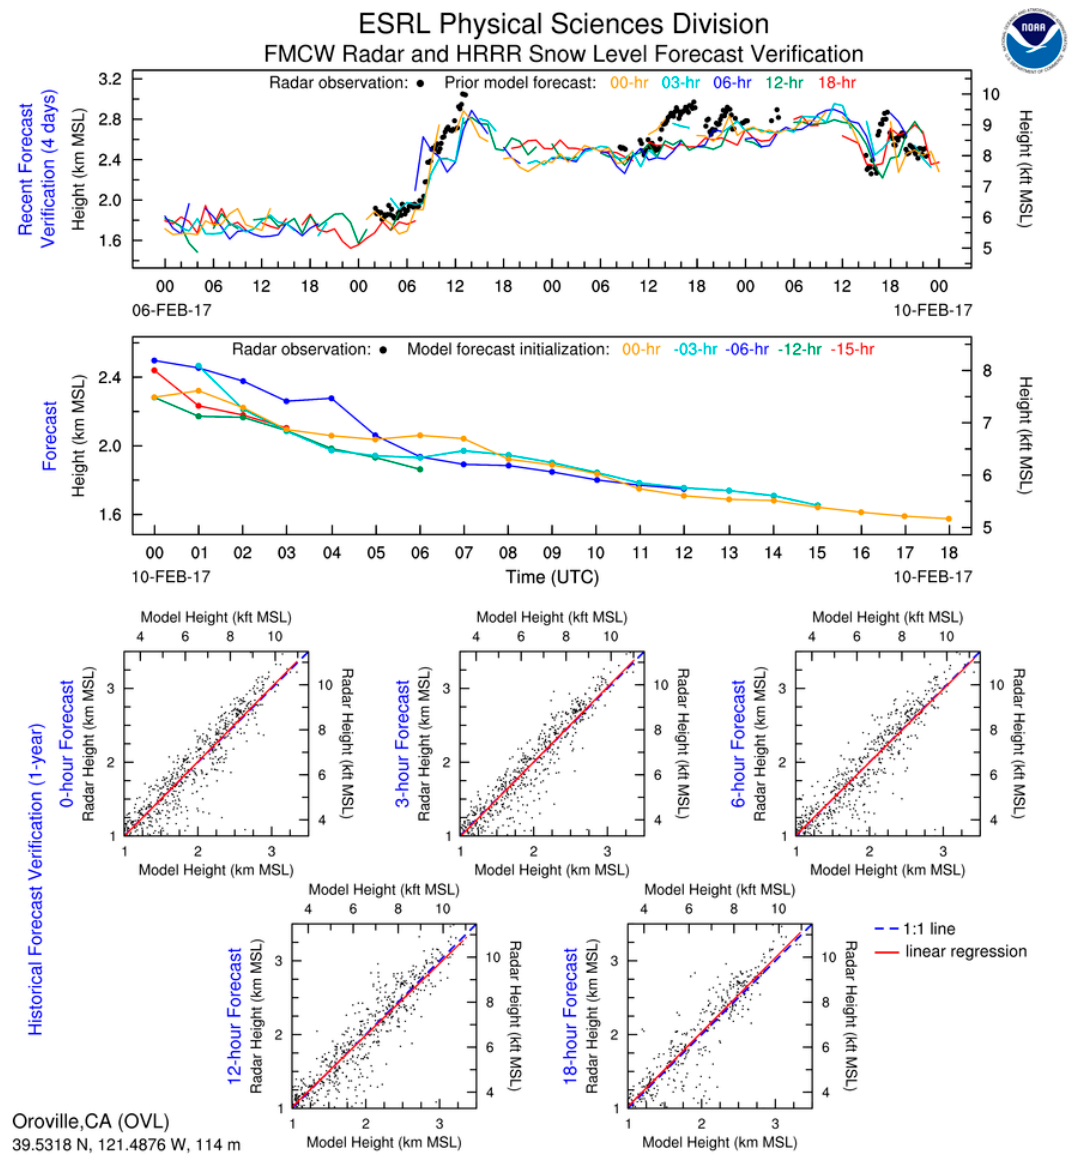
Figure 3. Snow level detection and verification tool comparing observed snow levels with forecasted snow levels by the HRRR. Upper panel: radar-based snow level observations (km; black dots) and HRRR snow level forecasts (km; colored lines for different lead times). Middle panel: snow level radar observations (black dots) compared to forecasts (colored lines for the current forecast). Lower panel: Five graphs show the historical forecast verification for snow level for at forecast lead times from 0- to 18-h. This tool is available to forecasters and the general public online by selecting the Snow Level Verification Plot at https: // www.esrl.noaa.gov / psd / data / obs / datadisplay / tools /